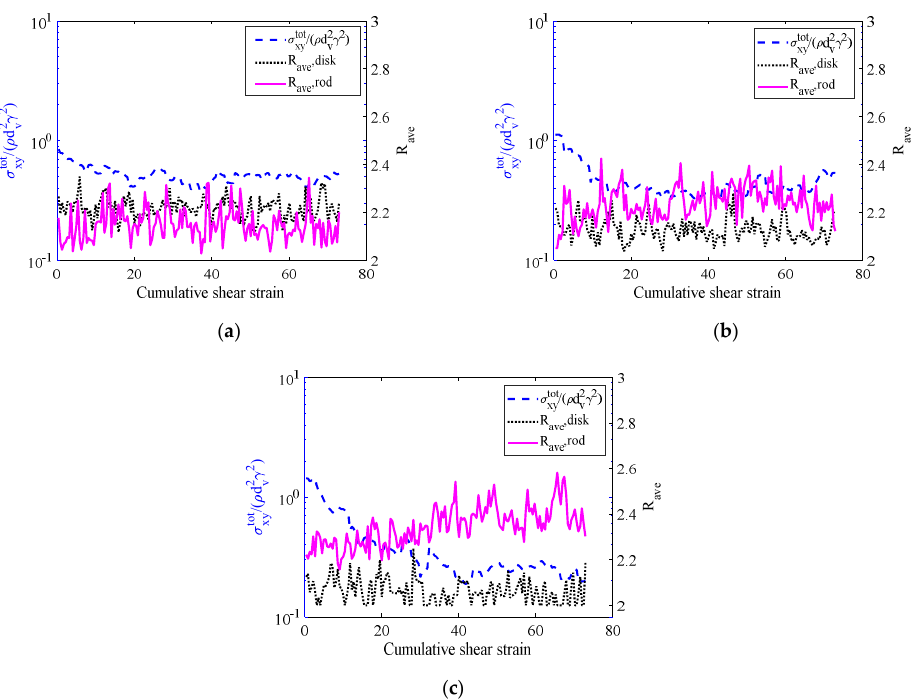
( f ) Figure 6. Evolution of normalized shear stress, average stack size   (first row), fraction of stacking particles P (second row), and order parameter S (third row) with cumulative shear strain for the monodisperse shear flows with disks of AR = 0.3 (first column) and rods of AR = 6 (second column): ( a ) R ave versus cumulative shear strain for AR =0.3, ( b ) R ave versus cumulative shear strain for AR =6, ( c ) P versus cumulative shear strain for AR =0.3, ( d ) P versus cumulative shear strain for AR =6, ( e ) S versus cumulative shear strain for AR =0.3, ( f ) S versus cumulative shear strain for AR =6. The solid volume fraction is  = 0.5. 3.2. Binary Mixture Flows Shear flows of binary mixtures of rods and disks, which have the same particle volume, are simulated to examine the effect of particle shape difference on the stacking and ordering behavior. Figure 7 shows the evolution of normalized shear stress and average stack size   with cumulative shear strain for binary mixture flows with various rods fractions  . In the binary mixtures, rods and disks have aspect ratios of AR = 6 and AR = 0.3, respectively, and the solid volume fraction is set to  = 0.5. A stack is formed by particles of the same shape, as shown in Figure 4b. Thus, the stack sizes are measured for the rods and disks separately. As shown in Figure 7a, for a binary mixture with C = 0.25, the average shear stress initially decreases and then approaches a steady-state value. The average stack sizes, which are the same for the rods and disks, remain constant in the flow process. As the rods fraction C increases (Figure 7b and 7c), an initial decrease in the shear stress is also obtained; however, a larger magnitude of the stress decrease is observed. The average stack size of the disks with AR = 0.3 still remains constant, while the average stack size of the rods with AR = 6 shows a slight increase with the cumulative shear strain.